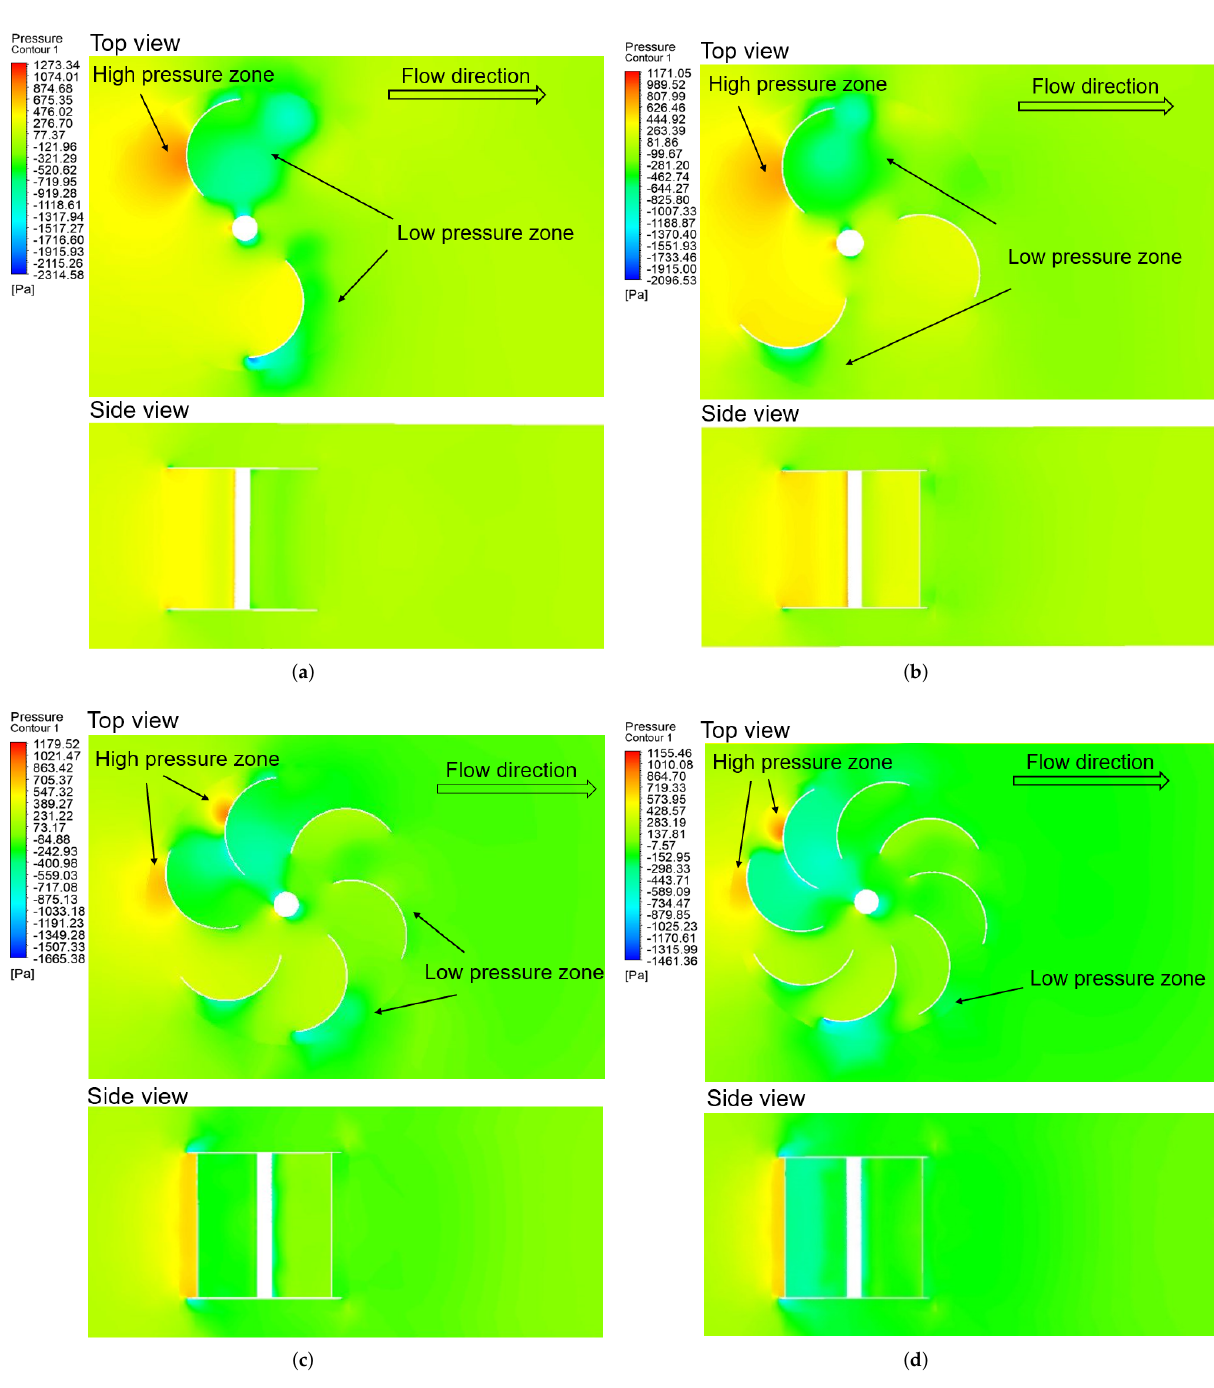
Figure 14. Comparison of the pressure distribution around the blades for ( a ) 2-bladed turbine, ( b ) 3-bladed turbine, ( c ) 6-bladed turbine, and ( d ) 8-bladed